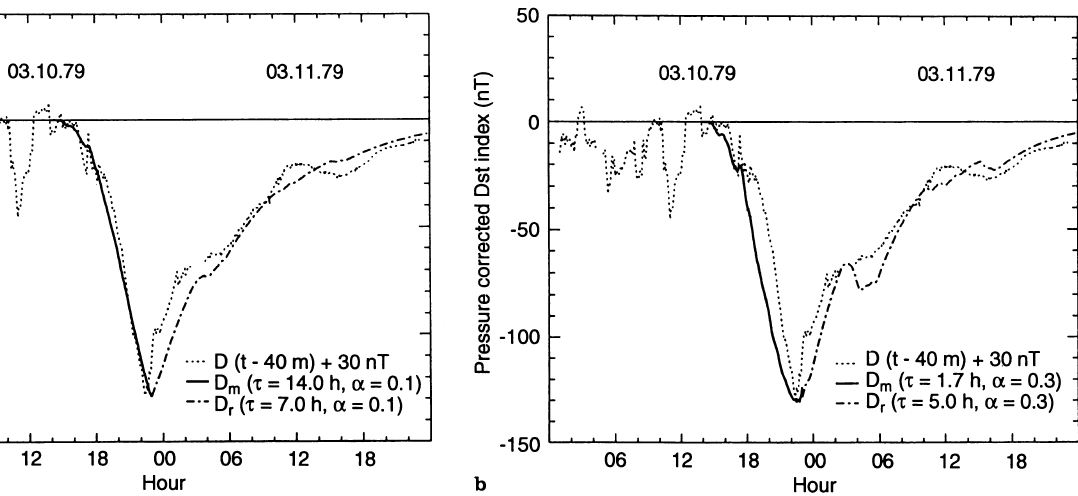
Fig. 6. a Numerical simulation of the response of D ( t ) to the energy input given by Eq. (10) for event 2, for a (cid:136) 0 : 1 : The dotted line gives the computed values of D ( t ), derived from Dst and ISEE-3 data (Eq 1). The solid line (cid:133) D m (cid:134) is the result of the numerical integration of Eq. (3), starting at the time the storm began, for D (0) = 0 and